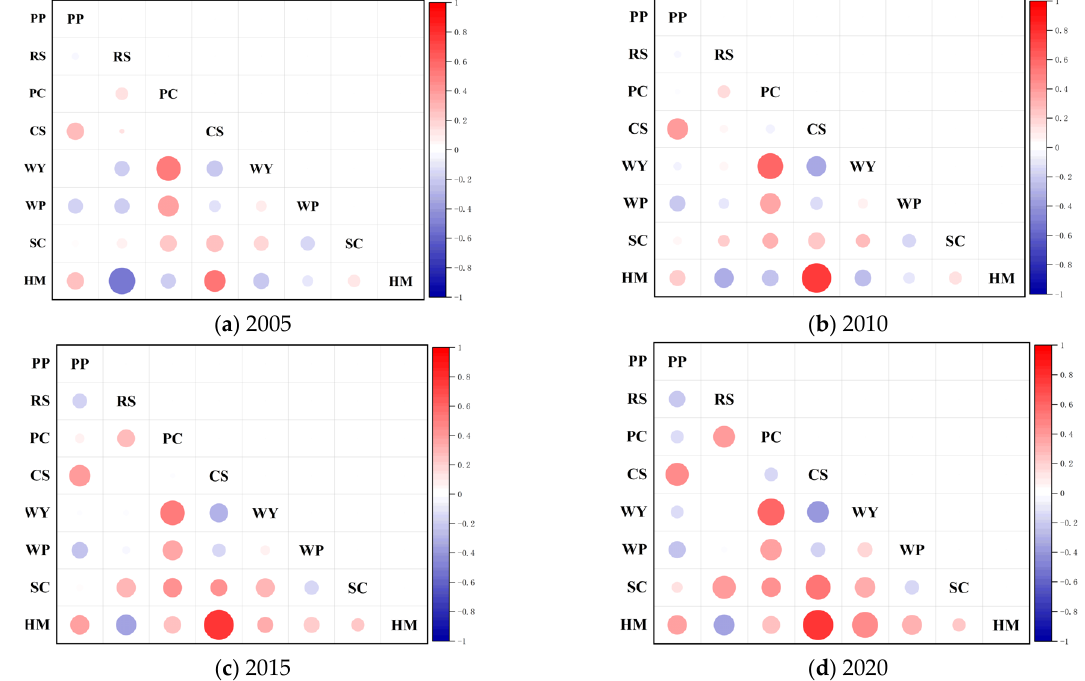
Figure 6. Correlations among landscape functions in Jiawang from 2005 to 2020.